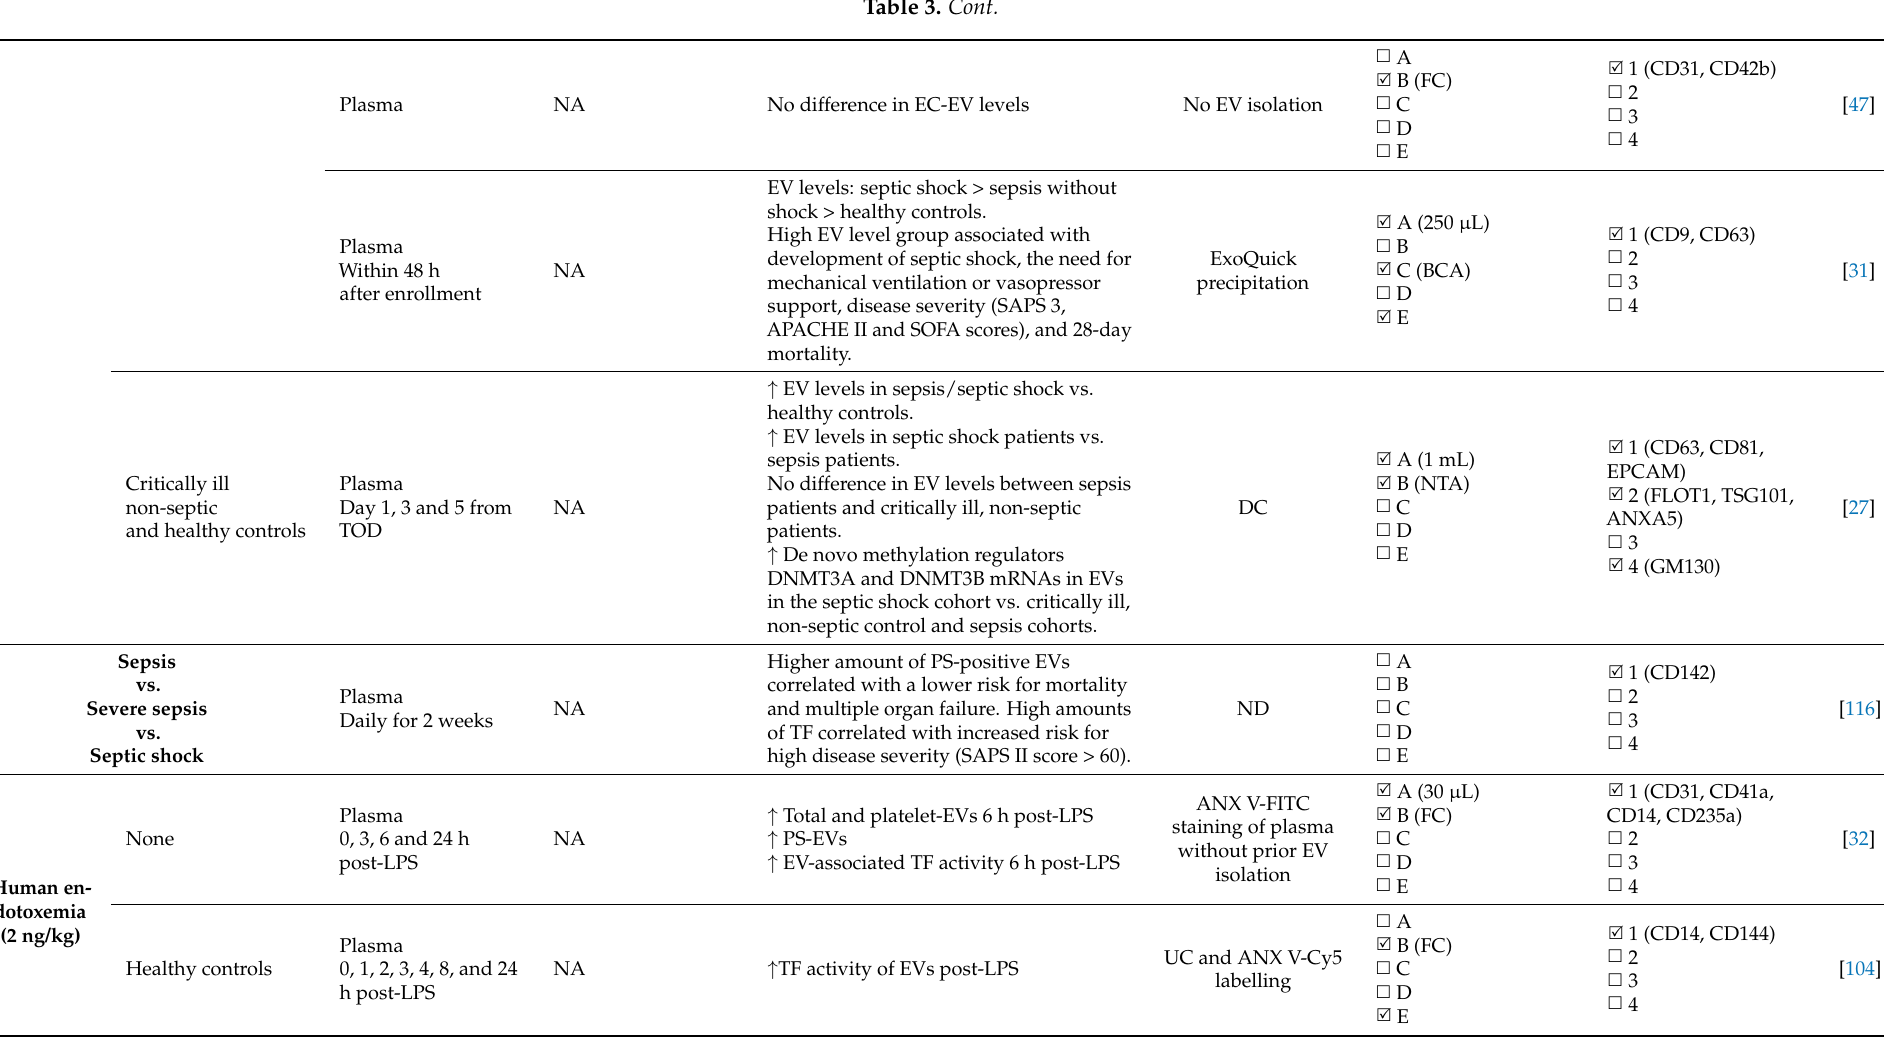
EVs and platelet count at D1 could predict DIC ab- sence. Total EV amount in same range for DIC and non-DIC patients.